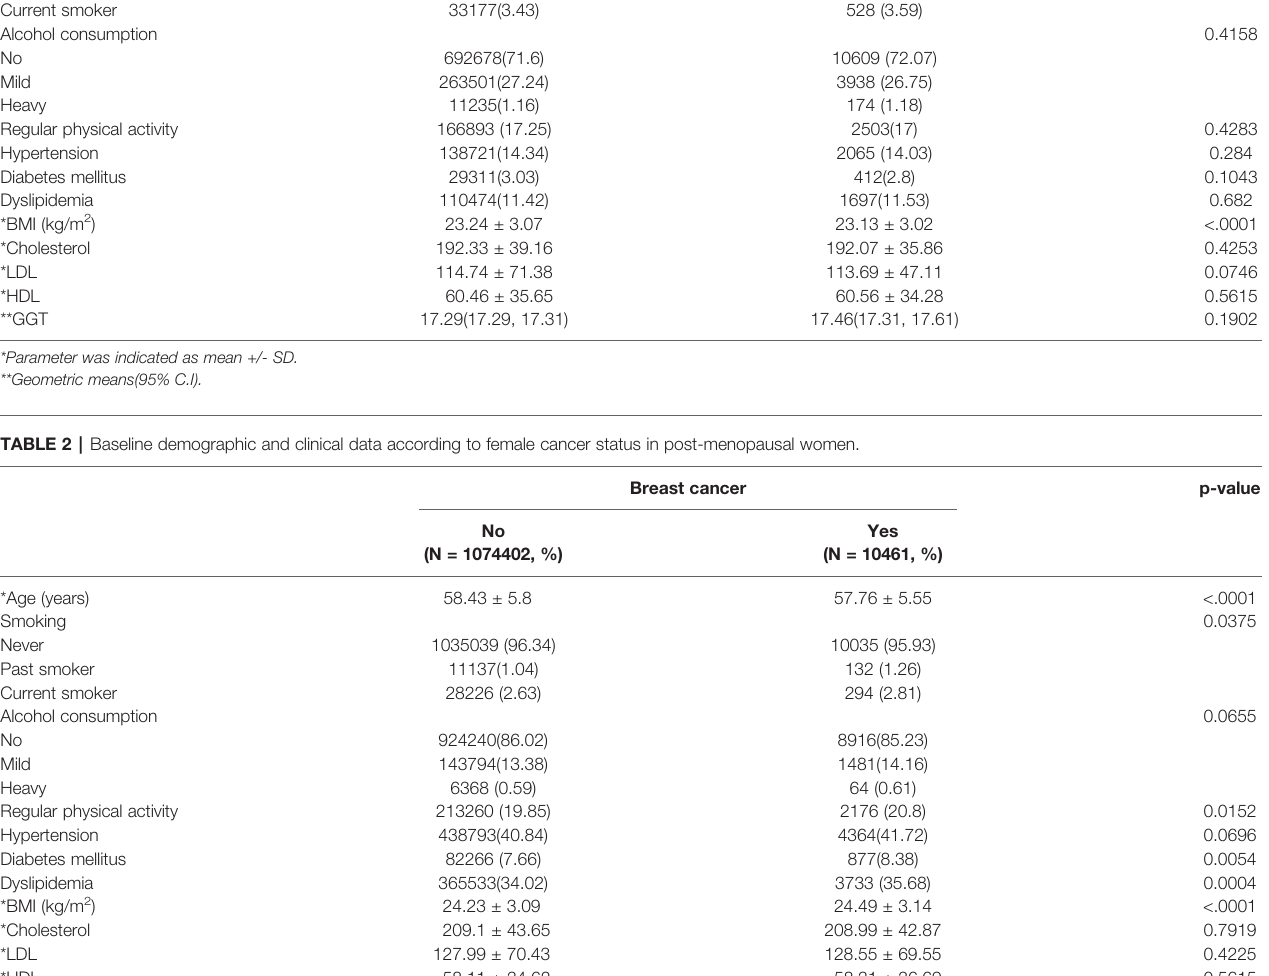
TABLE 1 | Baseline demographic and clinical data according to female cancer status in pre-menopausal